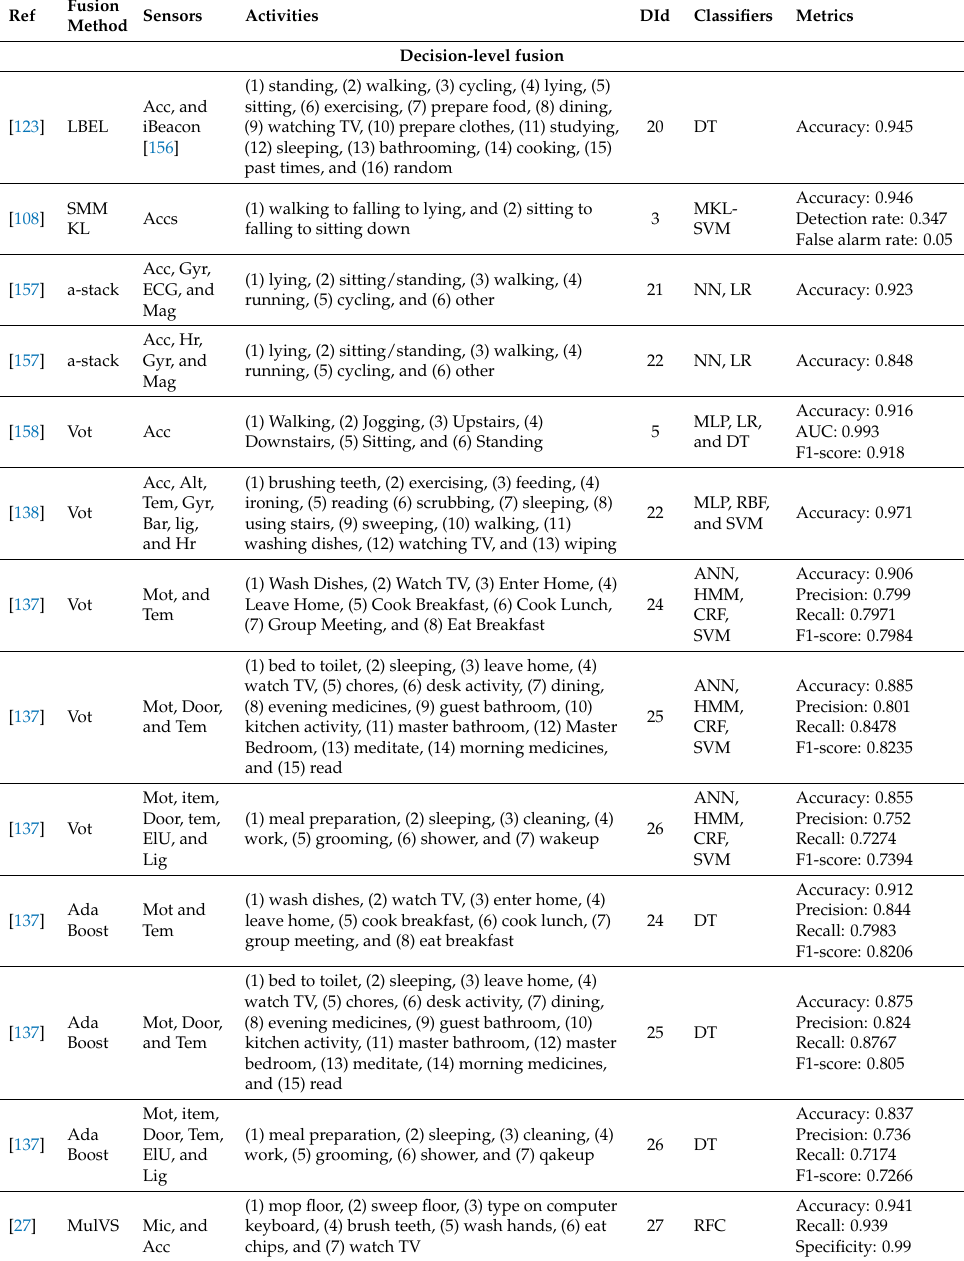
Table 10. Summary of works proposing methods that combine data at the decision level. Ref = Reference and DId = Dataset ID. Acc(s) = Acceleromter(s), Mag(s) = Magnetometer(s), Gyr(s) = Gyroscope(s), ECG = Electrocardiography, Hr = Heart rate, Alt = Altimeter, Tem = Temperature, Bar = Barometer, Lig = Light, Mot = Motion, ElU = Electricity usage, Mic(s) = Microphone(s), OMCS = Optical motion capture system, Kc = Kinect camera, and Vid(s) =